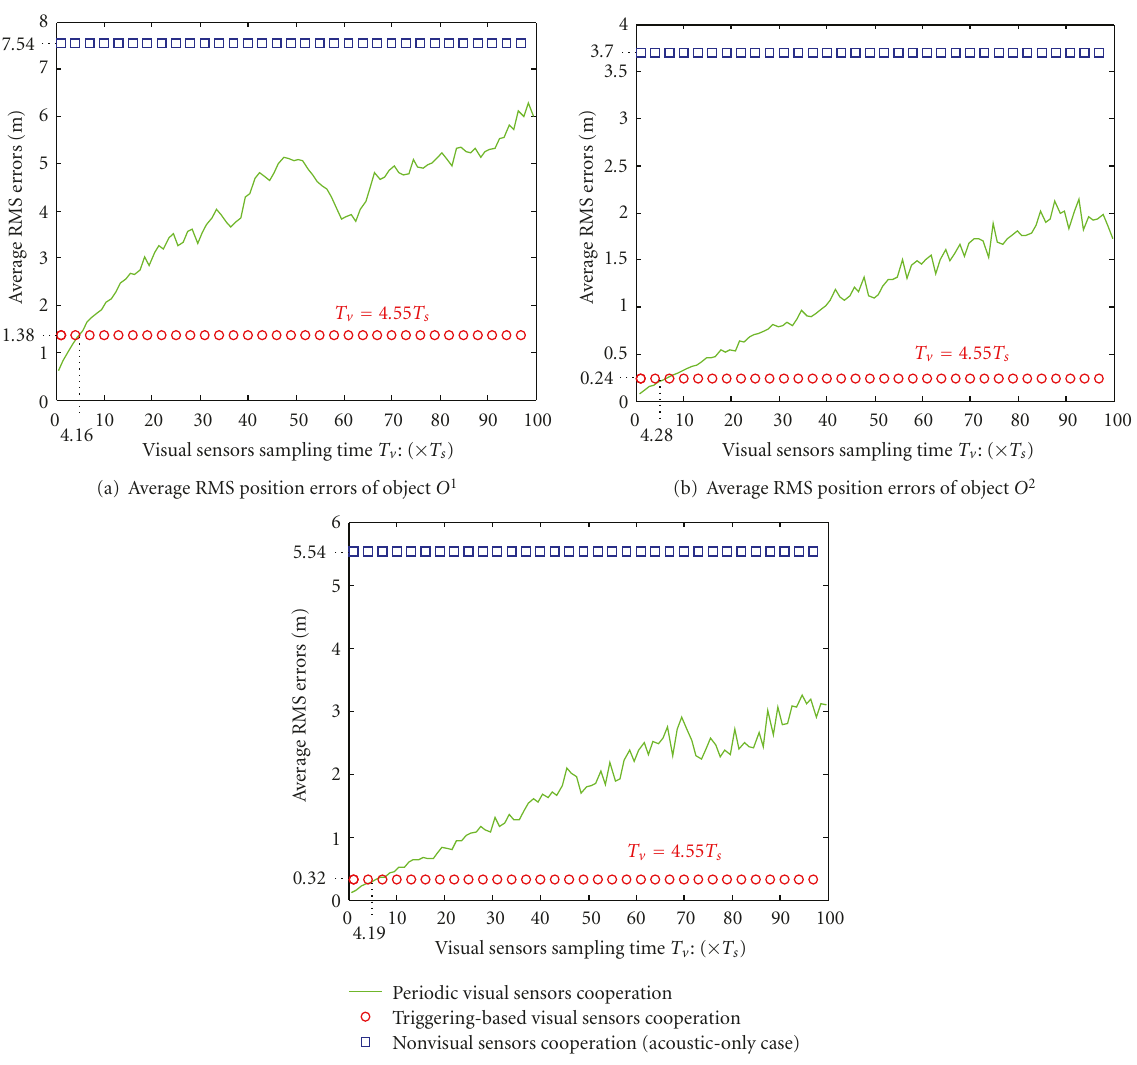
Figure 13: Average RMS position errors with three cooperation approaches. For the periodic visual sensor cooperation, the period varies from 1 T s to 100 T s